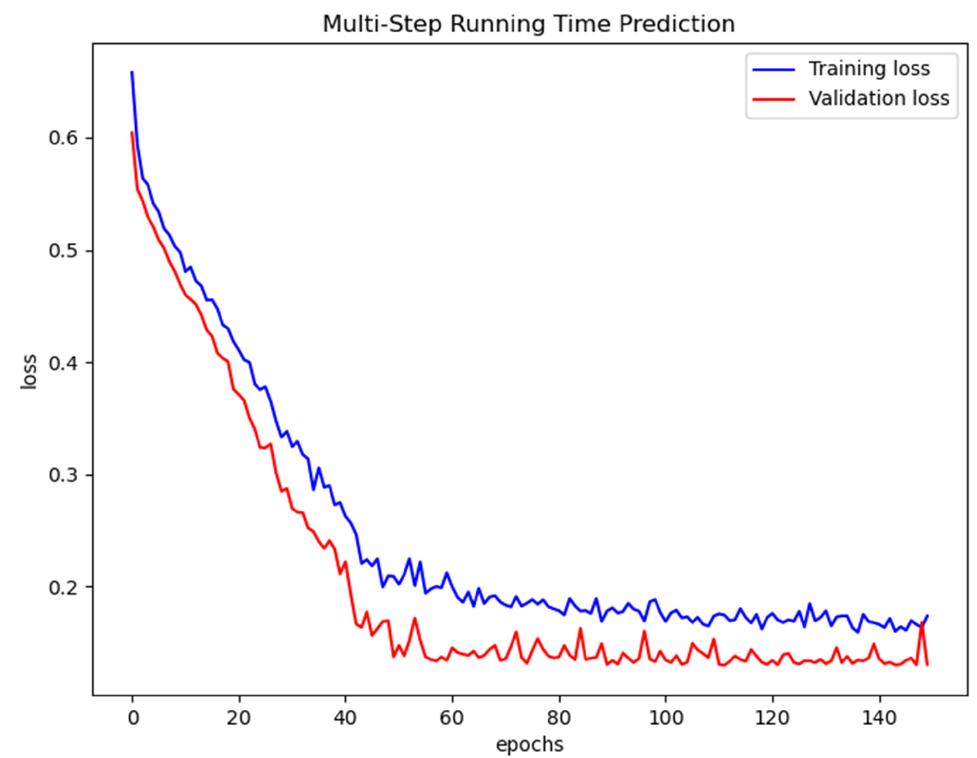
Future Transp. 2021 , 1, FOR PEER REVIEW Figure 4. Training and validation loss for a running time prediction with MAE as loss function.